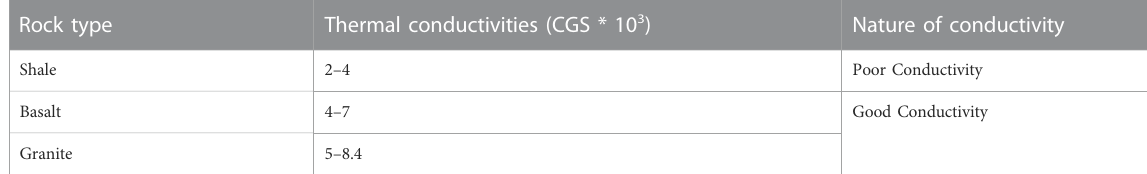
TABLE 5 Ranges of thermal conductivity values for some typical lithology (Garcia-Gutierrez et al., 2002). Rock type